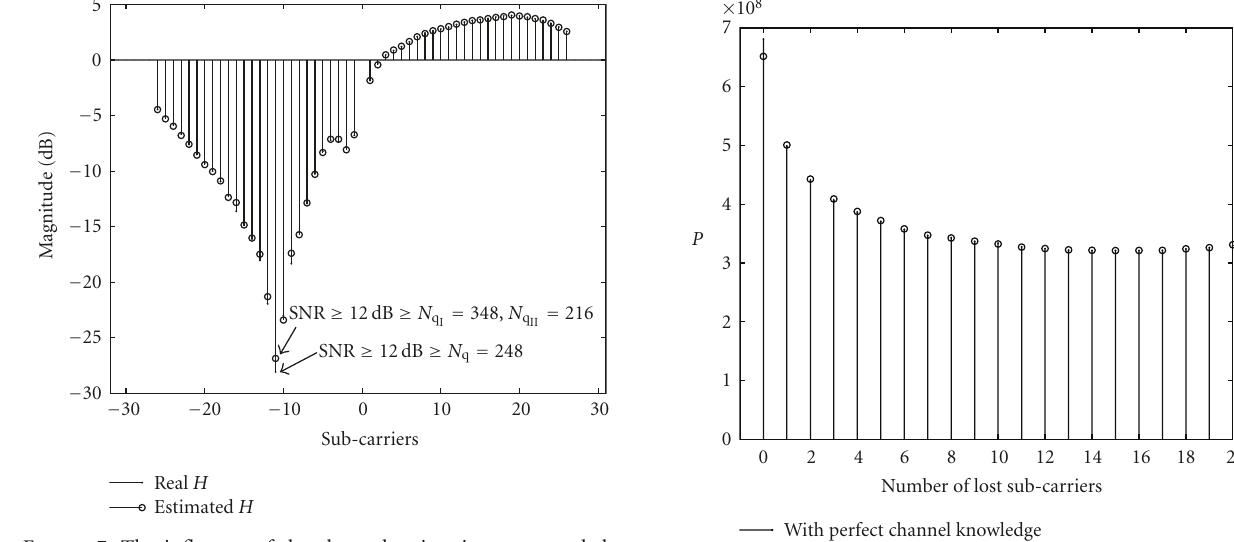
Figure 7: The influence of the channel estimation error and the di ff erence in N q between the quantization design Method I and the quantization design Method II. In this example, we assume the worst subcarrier has an SNR of 12dB. N q = 248 for the case with perfect channel knowledge. With the estimated channel knowledge, N q = 348 for the quantization Method I and N q = 216 for the quantization Method II.